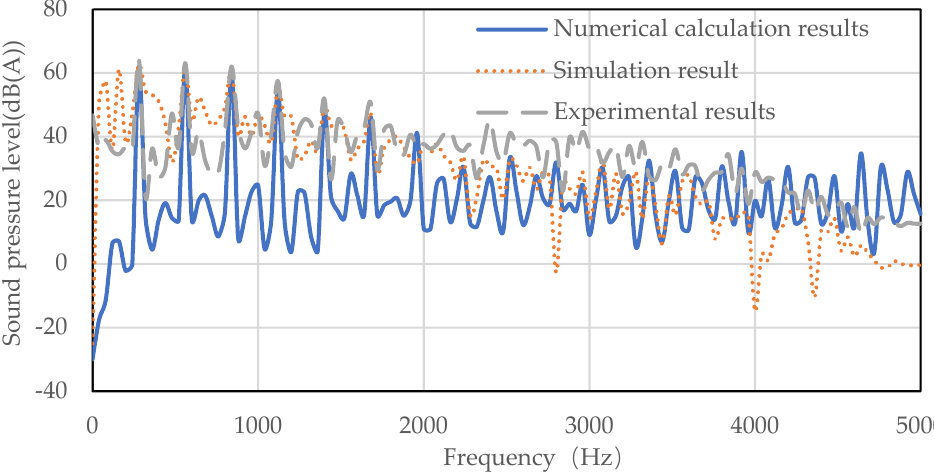
Figure 13. Single fan noise comparison of numerical calculation, simulation, and test results.